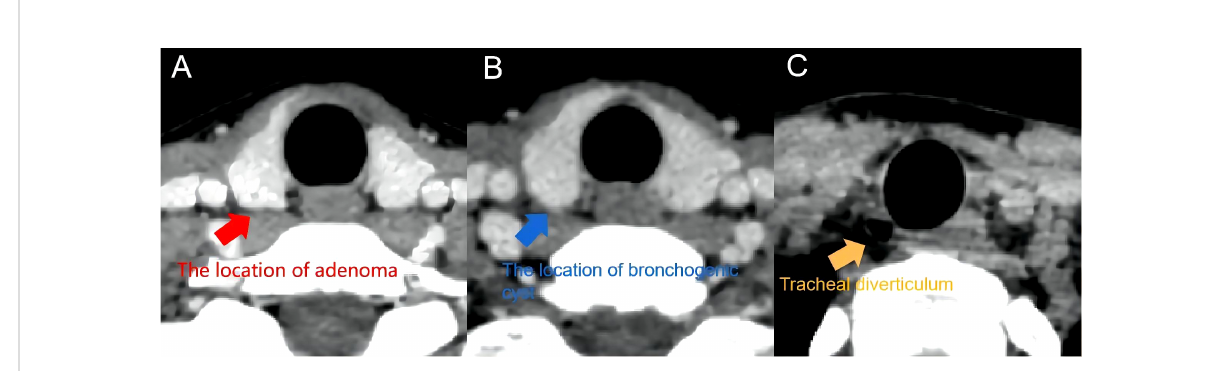
FIGURE 4 Postoperative CT. (A) the location of adenom in postoperative CT. (B) the location of cervical bronchogenic cyst in postoperative CT. (C) tracheal diverticulum in postoperative